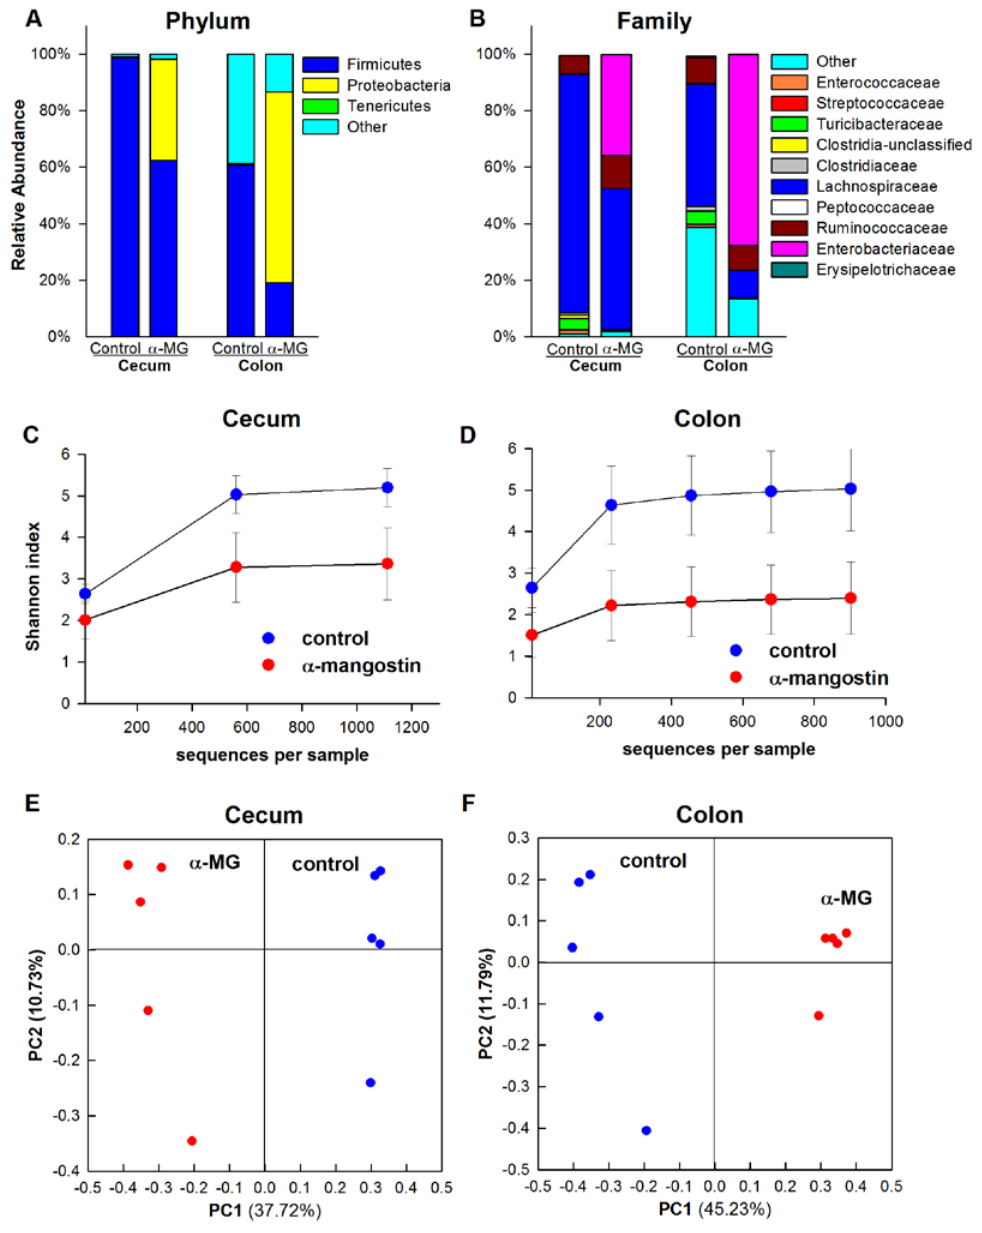
Figure 6. Altered composition in the microbiota of athymic FoxN1 nu mice fed diet containing α-MG. Dietary α-mangostin (α-MG) changes the relative abundance of bacterial communities in the cecum and colon of athymic FoxN1 nu mice at the ( A ) phylum and ( B ) family levels. Mice fed α-MG had significantly lower α-diversity) in ( C ) cecum and ( D ) colon compared to mice fed control diet. Panels E and F show principal coordinate analysis (PCoA) for cecum and colon, respectively. Samples in the α-MG group (red) cluster together and away from those in control group (blue). Data are for tissues collected from 5